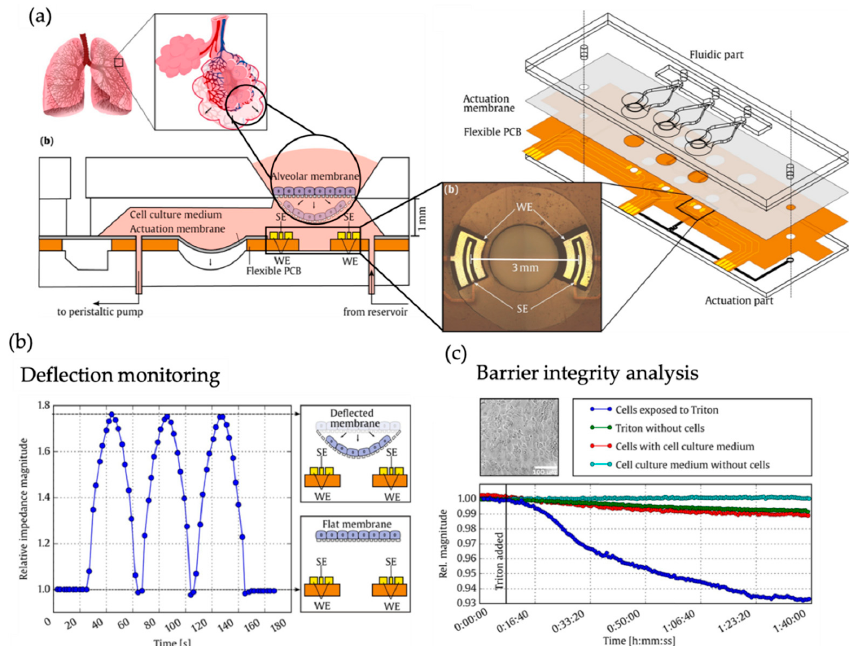
Figure 4. ( a ) Microimpedance tomography (MITO) system within lung-on-a-chip including sensing electrodes (SE) and working electrodes (WE). ( b ) Changes in impedance resulting from the respiratory movements of the cell culture membrane. The relative impedance changes result from the permeabilization of the epithelial monolayer. ( c ) Time-lapse relative impedance magnitude at a frequency of 1 kHz. (Adapted from [45] with permission from